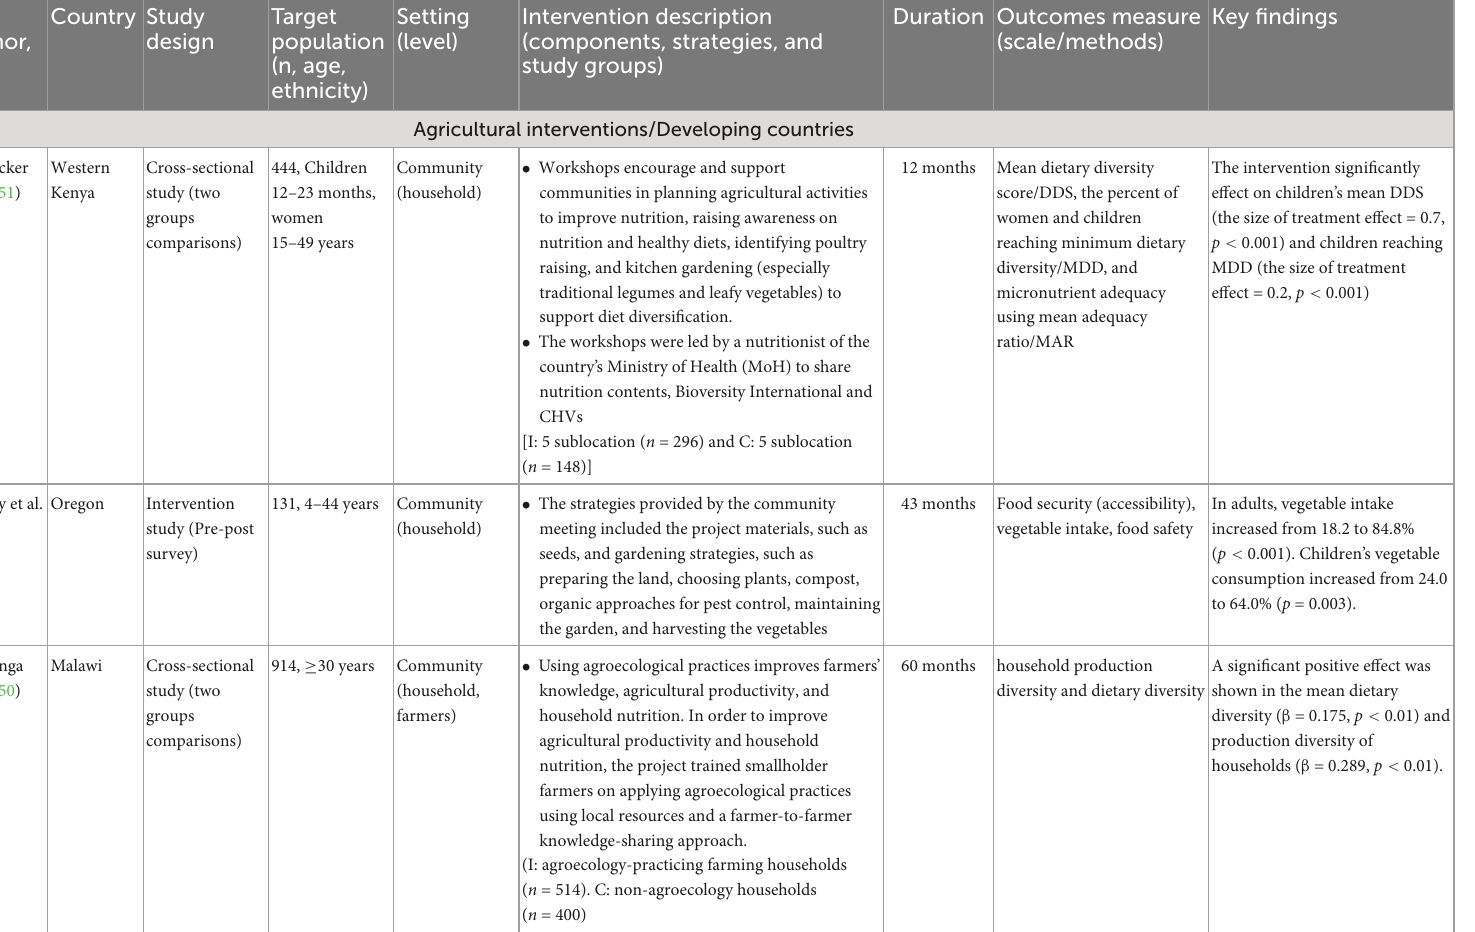
TABLE 3 Baseline characteristic of included studies ( n =